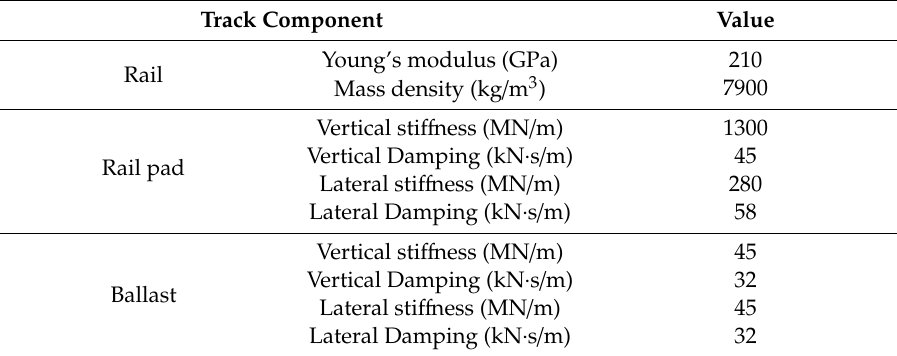
Table 2. Track properties of the MBS